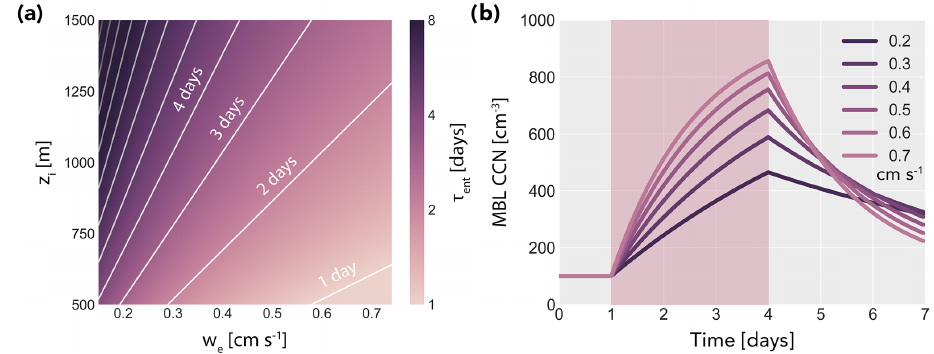
Figure 7. (a) Characteristic (e-folding) entrainment mixing timescale for a range of plausible z i and w e values. Contours at 1-day intervals for reference. (b) Evolution of CCN MBL over time in response to the introduction of a smoke plume with CCN FT = 1000cm − 3 at day 1 and its removal at day 4 (highlighted). Curves show results for a range of entrainment timescales with z i = 1km and w e varying between 0.2 and 0.7cms − 1